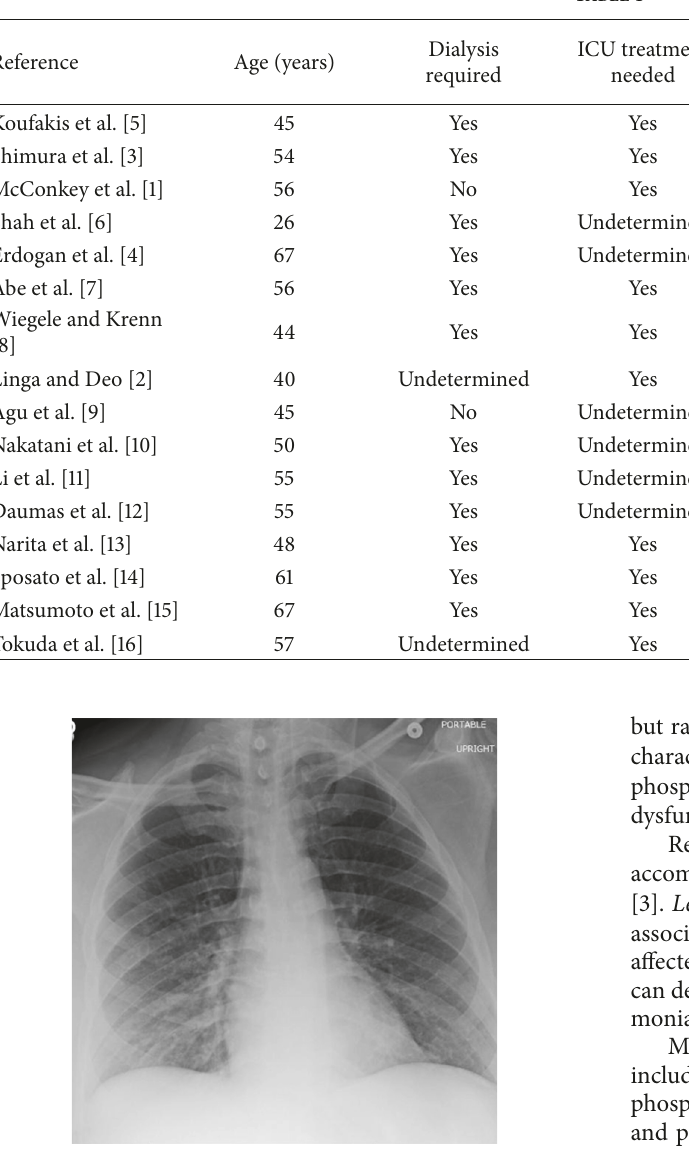
total bilirubin 0.2 mg/dL. After three-weeks follow-up in the outpatient setting, his creatine was back to normal at